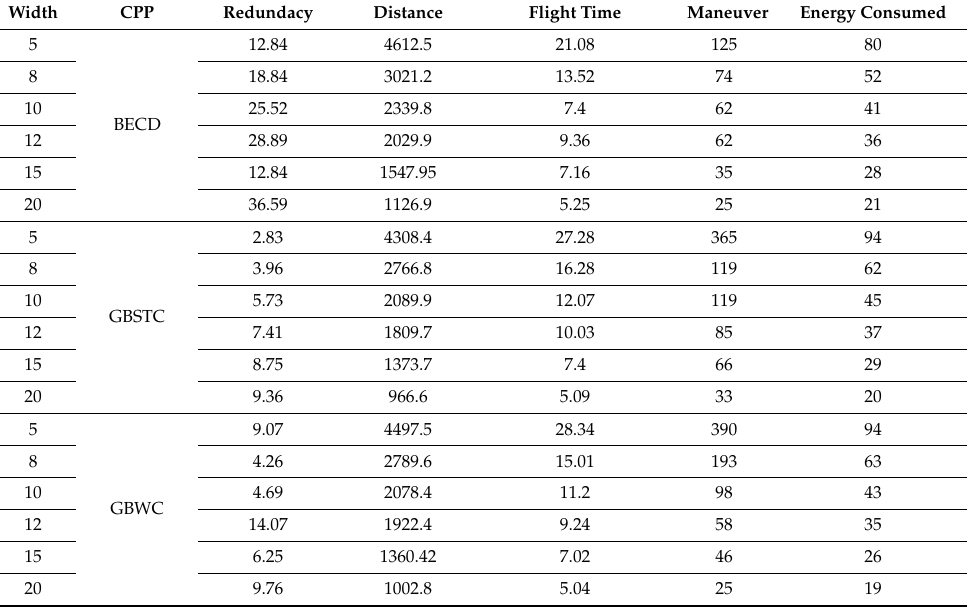
Table A3. Experiment 2 with three CPP methods implemented using Typhoon UAV over Arak PV